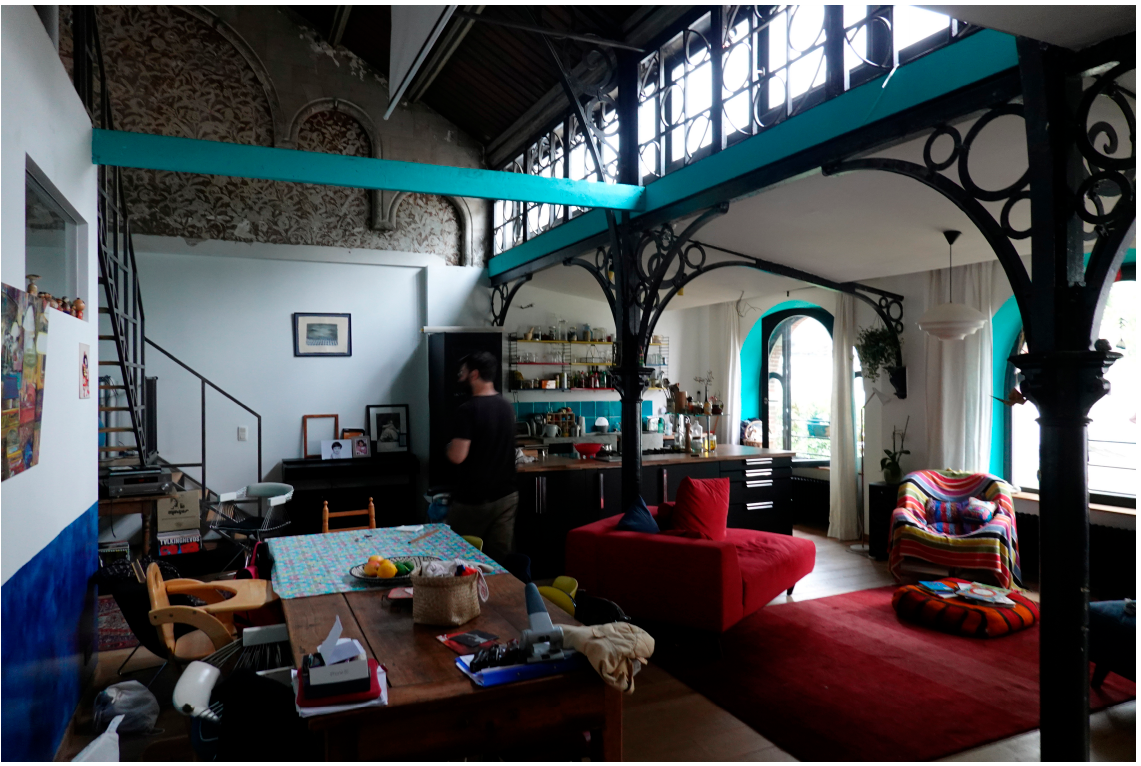
Figure 7. François and Nadine’s open kitchen (photo by the authors, 2019).